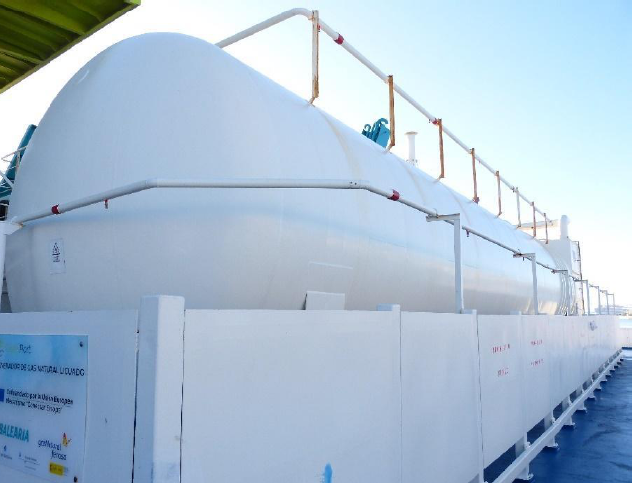
Figure 2. View of LNG storage tank onboard the ship “ABEL MATUTES”. Source: The authors.